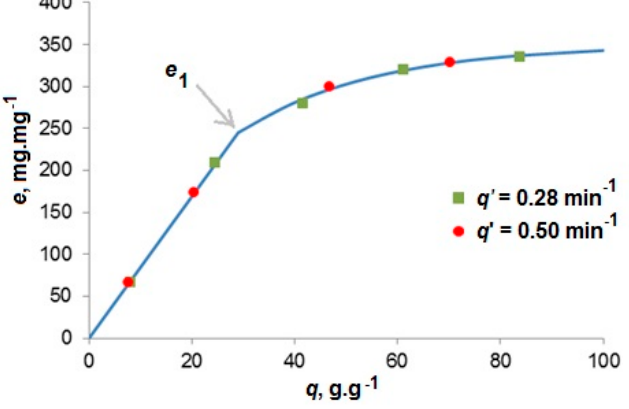
Figure 2. Yield of oil from Nannochloropsis sp. [11] at 30 MPa and 40 °C. The break of the curve is at the extraction yield e 1 . The specific flow rate is inversely proportional to the residence time.